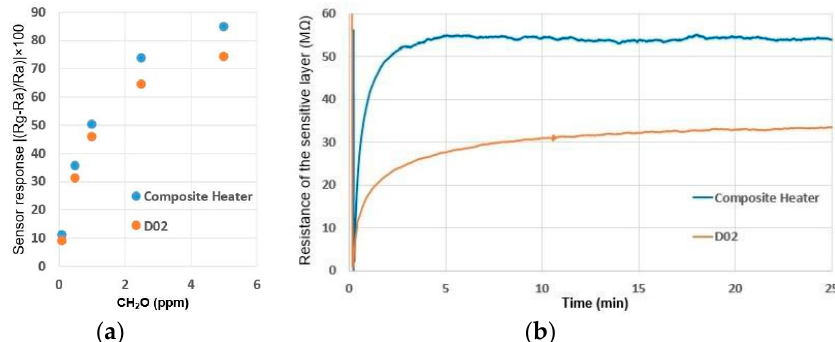
Figure 4. Sensing characteristics of the composite heater and the D02 design operating at 10.5 mW. ( a ) The gas sensor response towards formaldehyde gas at concentrations in the ppb and ppm range. ( b ) Baseline response of both sensors during operation for 25 min.